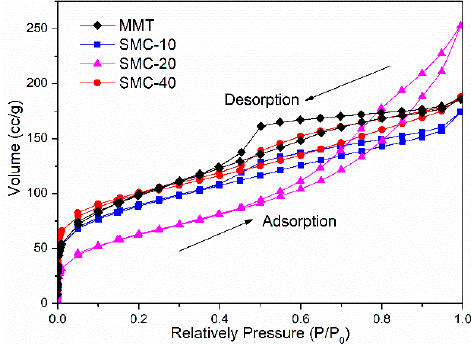
Figure 5. N 2 adsorption/desorption isotherms of MMT and silica/MMT nanocomposites. Table 1. Physical parameters of surface structure for MMT and silica/MMT nanocomposites. Samples